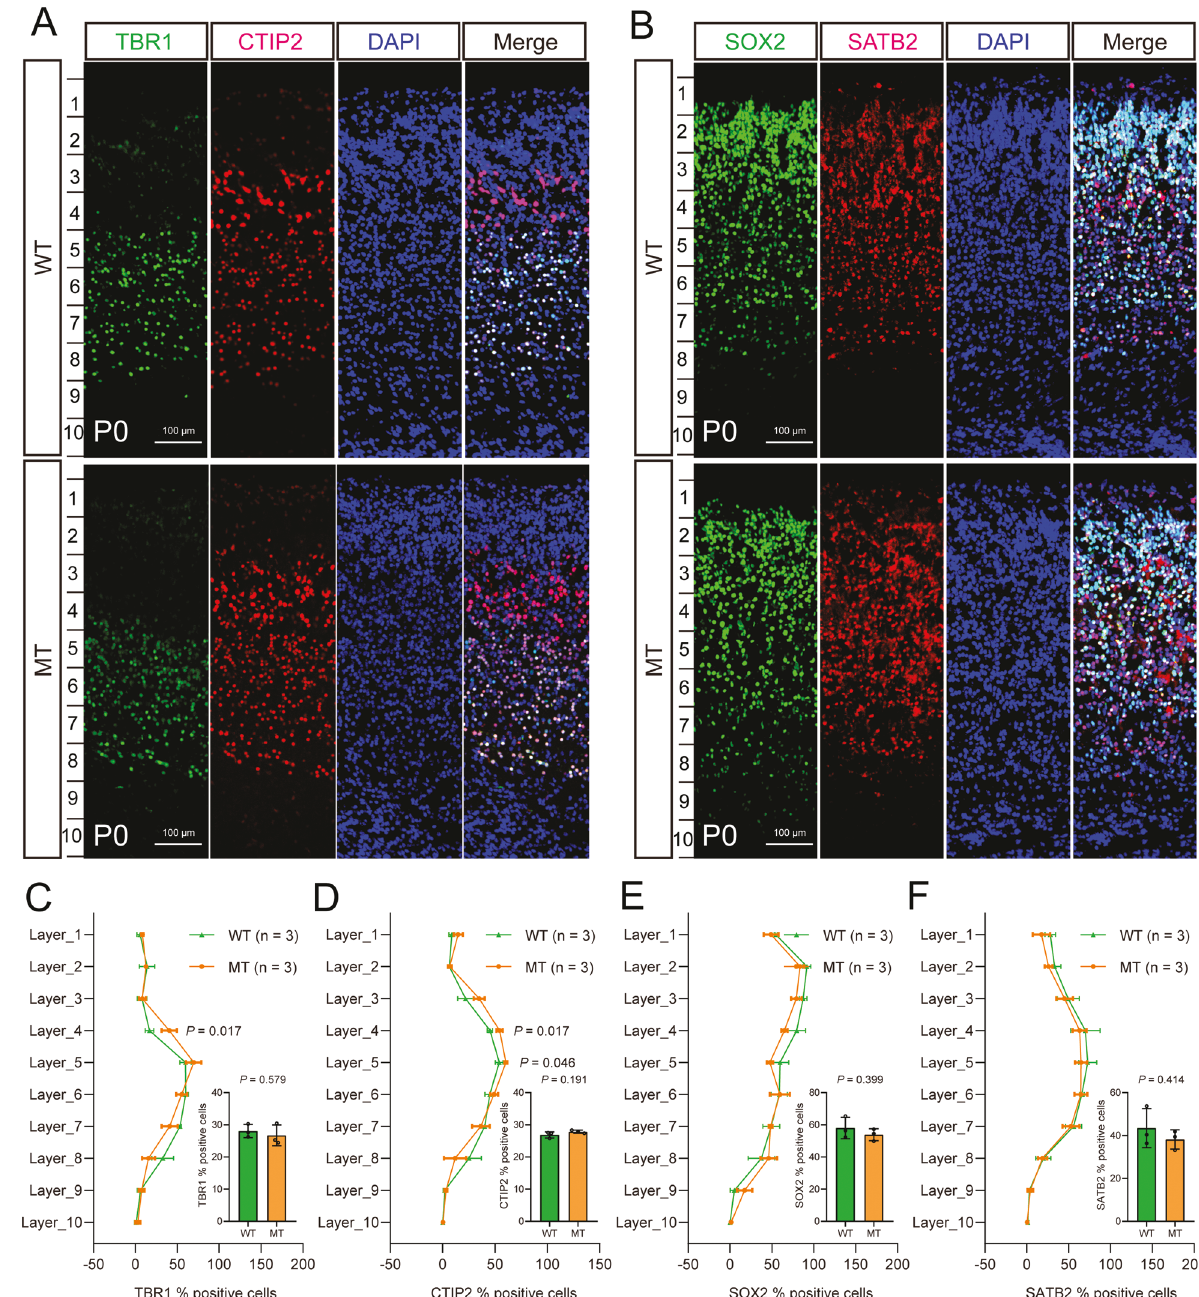
Fig. 3 Subtle effect of SLC39A8-p.393T on cortical development. A , B Representative immuno fl uorescence images for four cortical layer- speci fi c markers (TBR1, CTIP2, SOX2, SATB2) (P0 stage). C – F The subtle effect of SLC39A8-p.393T knock-in on cortical development.